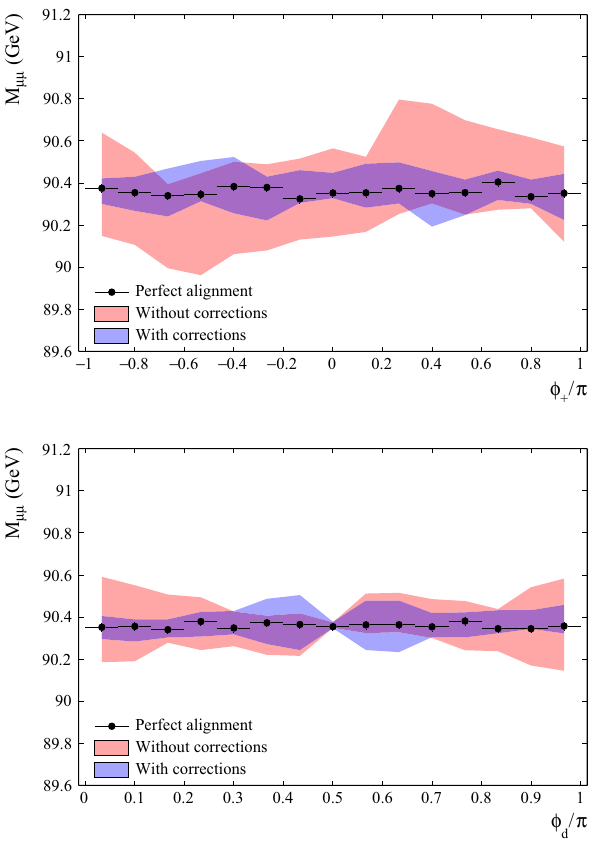
herent mis-alignment scenario before (after) application of the pseudo- mass method. The centre (width) of each band corresponds to the mean (RMS) of the ten toys